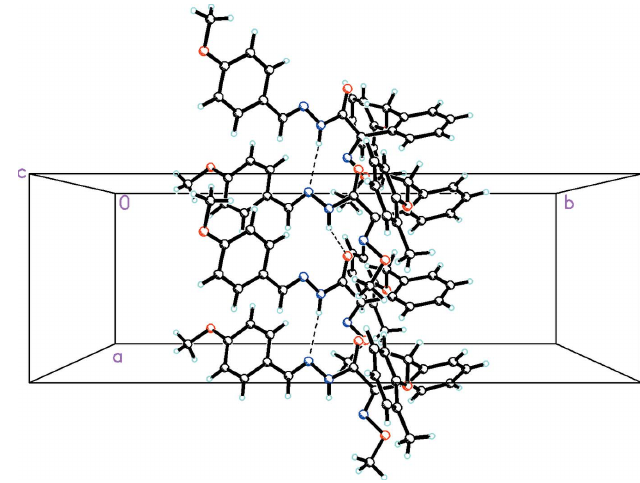
Figure 2 Molecules of the title compound are linked by N—H (cid:2)(cid:2)(cid:2) N and N—H (cid:2)(cid:2)(cid:2) O interactions (shown as dashed lines) into a zigzag chain propagating in the a- axis direction.